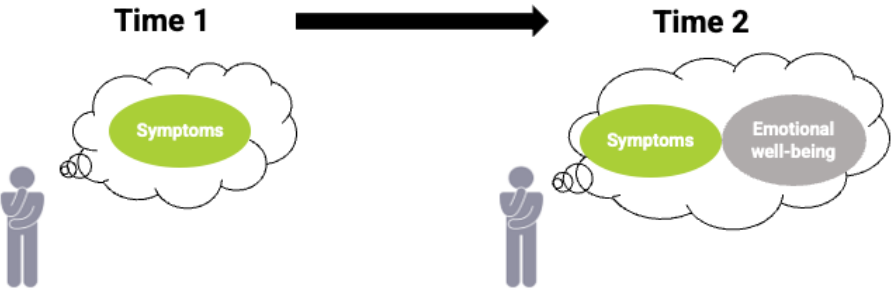
Figure 6. Bill has redefined what health means to him by including emotional well-being (reconceptualization).